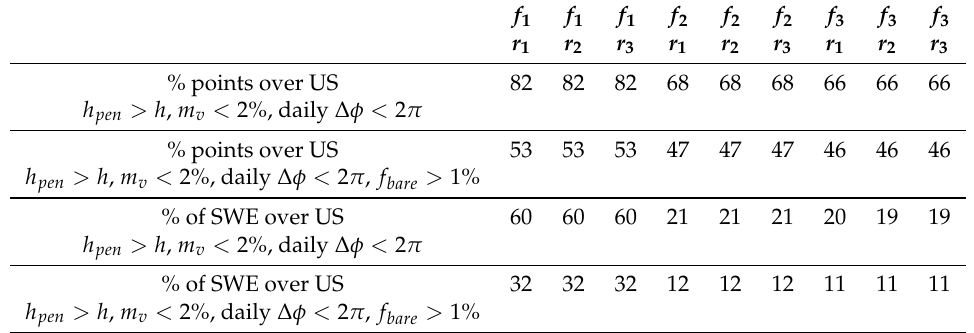
Table 4. US data satisfying the preconditions of the differential interferometry retrieval method in 2015, ( f 1 = 1 GHz, f 2 = 13.5 GHz, f 3 = 17.25 GHz , r 1 = 0.2 mm, r 2 = 0.5 mm, r 3 = 0.8